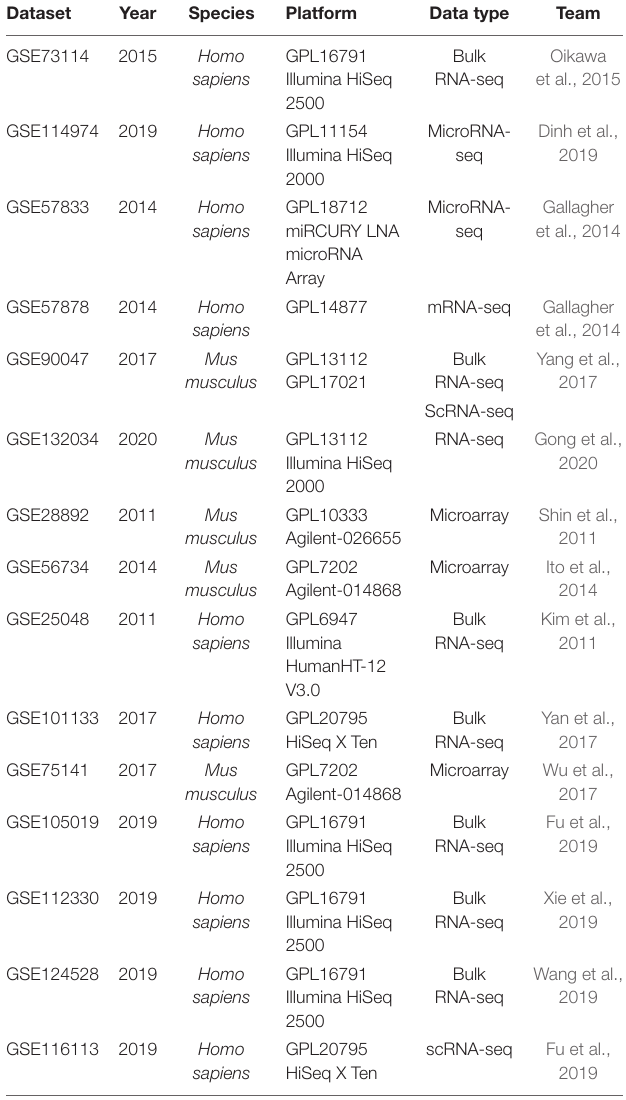
TABLE 1 | Detailed information of 15 datasets analyzed in this